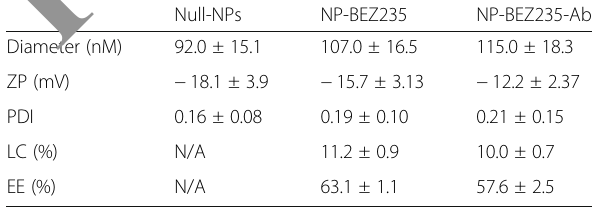
Table 1 Characteristics of